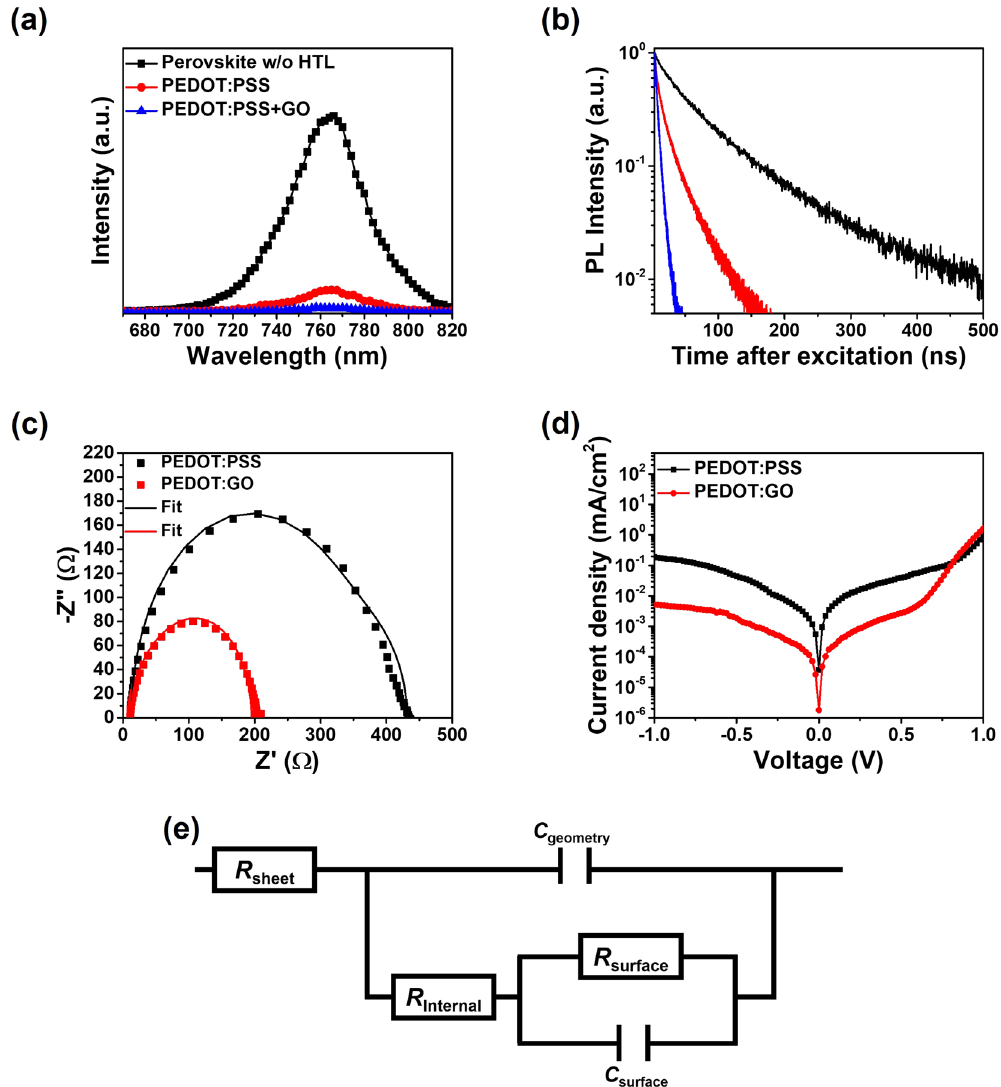
Figure 4. ( a ) Steady-state PL spectra and ( b ) time-resolved PL spectra of perovskite films prepared on PEDOT:PSS and PEDOT:GO composites, respectively. ( c ) Nyquist plots of perovskite solar cells